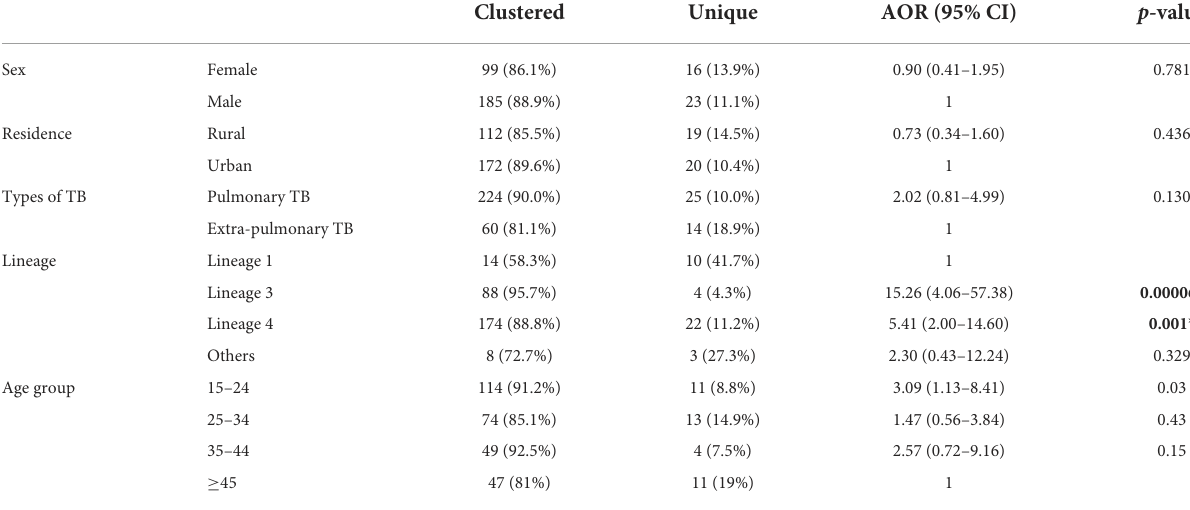
TABLE 1 Factors associated with clustering of M. tuberculosis complex in Somali, Ethiopia.